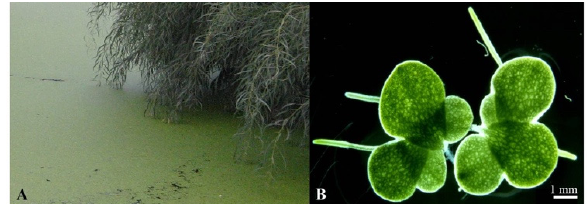
Figure 1. Duckweed in nature. ( A ) A natural population of the duckweed, Lemna gibba L., growing as a mat on the water surface. ( B ) Two colonies of L. gibba showing multiple generations of the plant vegetatively propagating. Left colony: The uppermost, large frond is the mother plant; its first daughter emerged from its left meristematic pocket and a second-generation daughter is in the process of emerging from the first daughter itself. Meanwhile, a daughter is also emerging from the mother frond’s right meristematic pocket. In this species, fronds typically have one root, several of which are seen. Photographed with illumination from below to accentuate parenchymal-cell air pockets (the lighter color areas), which generate the characteristic floating property of Lemna plants.